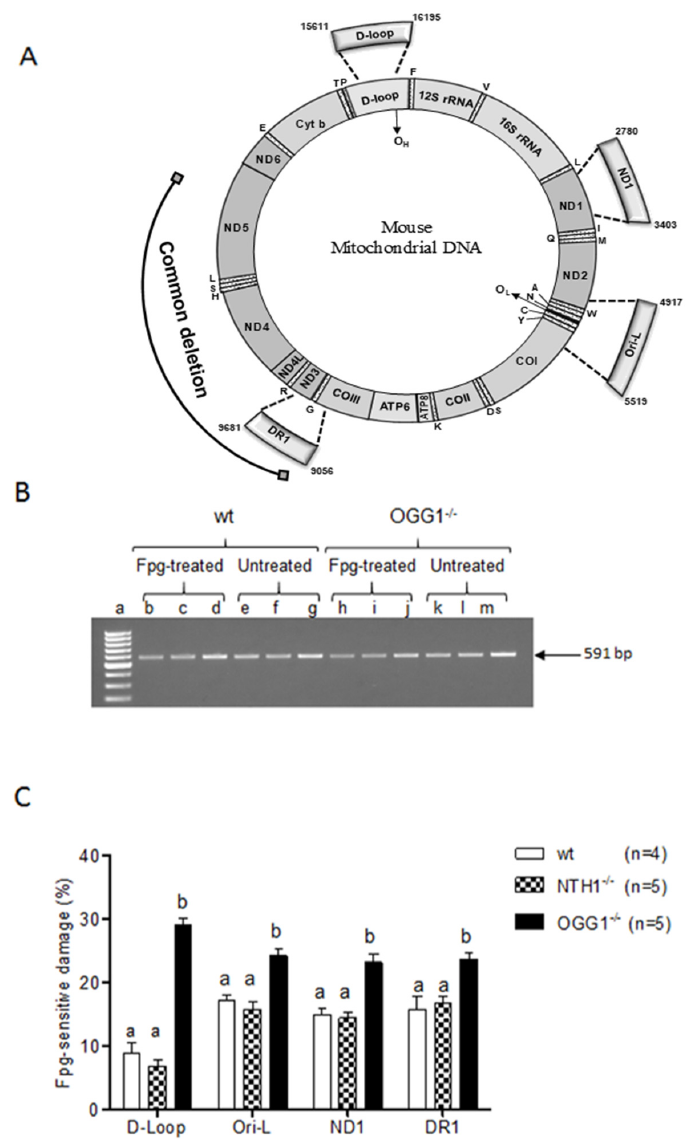
Figure 3. Analysis of purine-specific mtDNA damage at the d -loop, Ori- l , ND1, and direct repeat 1 (DR1) regions in liver from wt, NTH1 − / − , and OGG1 − / − mice. ( A ) Map of mouse mtDNA. The thick arches extending out of the circle represent the four amplified regions tested for formamidopyrimidine DNA glycosylase (Fpg) sensitivity delimited, respectively, by the primer pairs listed in Table 2, and corresponding to the indicated nucleotides. Numbering is according to National Center for Biotechnology Information (NCBI) accession number NC_005089.1. The outmost arch represents the 3.8-kb deletion, delimited by direct repeat 1 (DR1) and direct repeat 2 (DR2) represented by two full squares. ( B ) representative gel analysis of amplicons from Fpg-treated and untreated total DNA from one wt and one OGG1 − / − mouse (the target was the d -loop region). An aliquot (5 µ L) of each PCR reaction was loaded onto a 1.5% agarose ethidium bromide-stained gel and analyzed for band intensities. Lane loading was as follows: a = GeneRuler 100-bp DNA ladder (Thermo Fisher Scientific Inc, Waltham, MA, USA); b, c, e, f, h, i, k, and l = 5 ng of total DNA as template; d, g, j, and m = 7.5 ng of total DNA as template. ( C ) Bars represent the mean and SEM of the ratio between Fpg-treated and untreated band intensities, expressed as the percentage of the complement to 100 to improve the graphical evaluation. Statistical di ff erence determined by the Kruskal–Wallis test with Dunn’s multiple comparison test. Bars not sharing a common superscript letter di ff er significantly ( p <